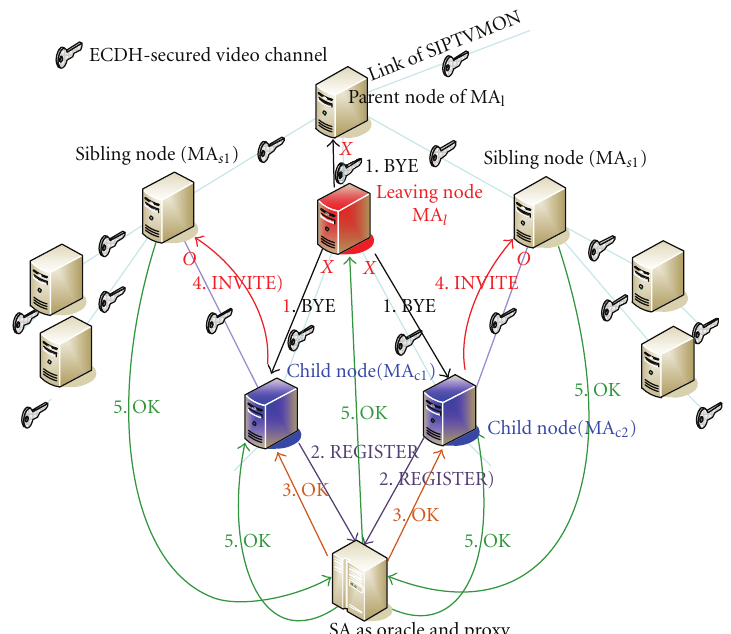
Figure 6: Message flow in leaving procedures of a nonleaf MA l with two